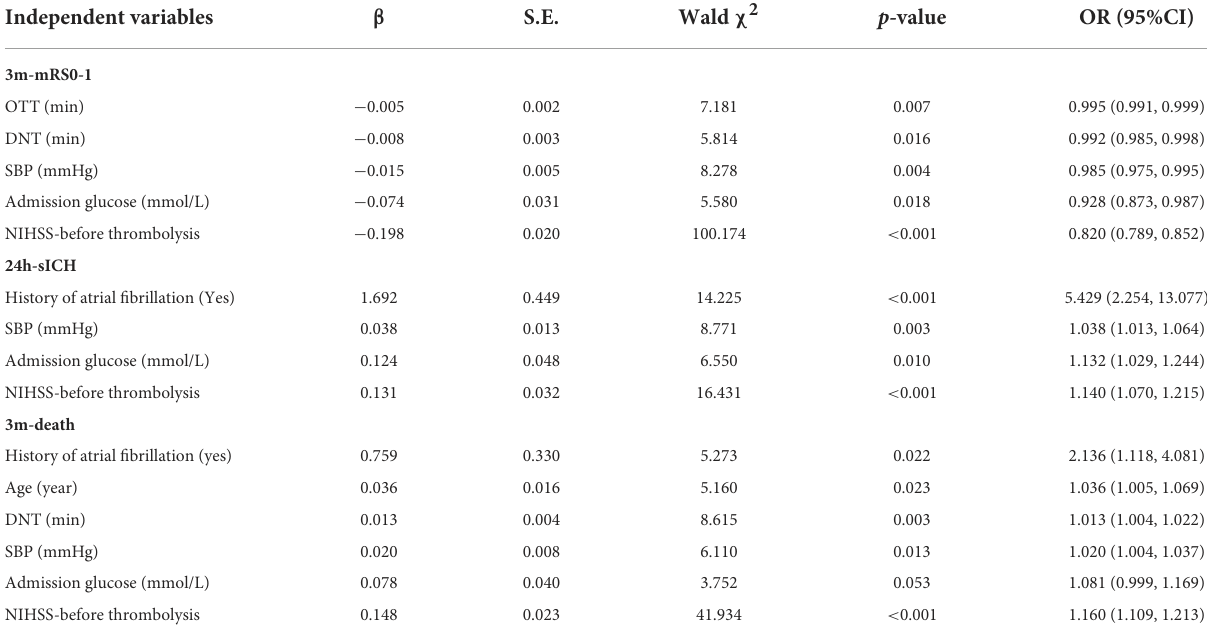
TABLE 2 Independent influencing factors of each outcome in total patients.